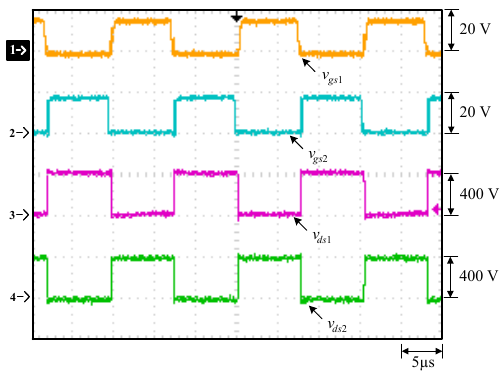
Figure 13. Waveforms at rated load: (1) v gs 1 ; (2) v gs 2 ; (3) v ds 1 ; (4) v ds 2 . Energies 2019 , 12 , x FOR PEER REVIEW